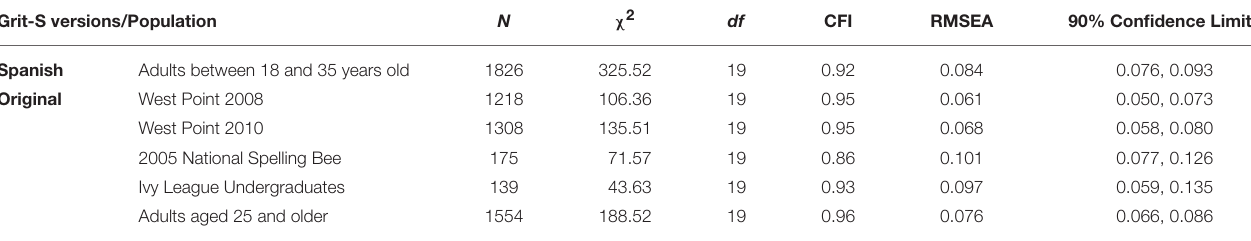
TABLE 4 | Fit information for the Two-Factor Model for the Spanish and Original Versions of the Grit-S Scale. Grit-S versions/Population N χ 2 df CFI Spanish